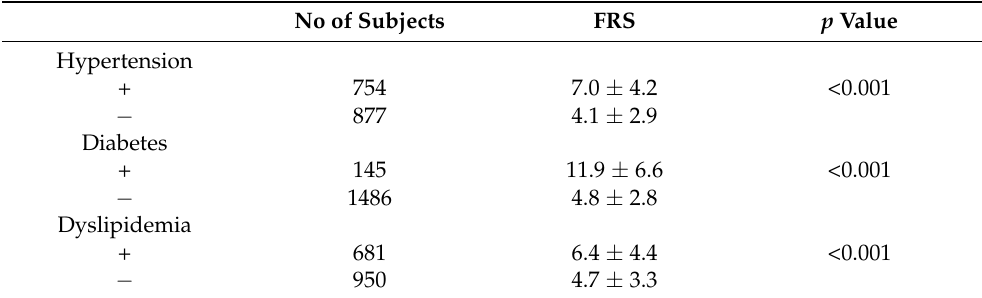
Table 4. Comparisons of FRS among participants with hypertension, diabetes, or dyslipidemia and those without them. No of Subjects FRS